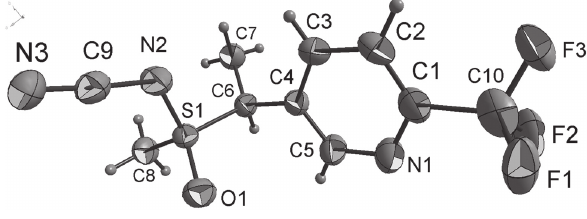
Table 1: Data collection and handling.